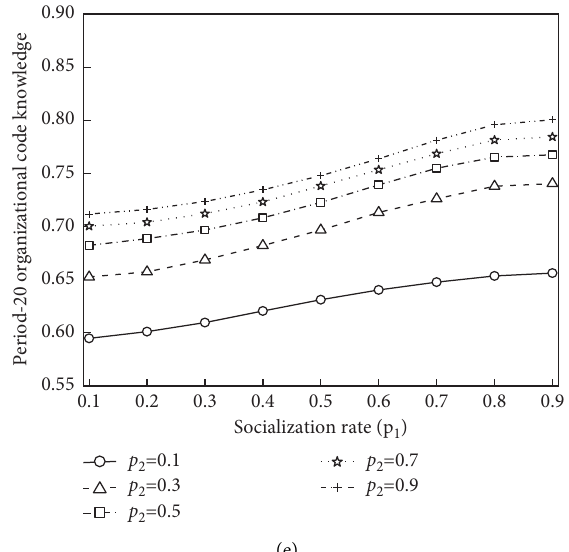
Figure 4: Effects of combinations of the socialization rate ( p 1 ) and codification rate ( p 2 ) on the organizational knowledge with different degrees of system openness in the stable environment ( p 4 � 0). (a) p 3 � 0.1. (b) p 3 � 0.3. (c) p 3 � 0.5. (d) p 3 � 0.7. (e) p 3 �